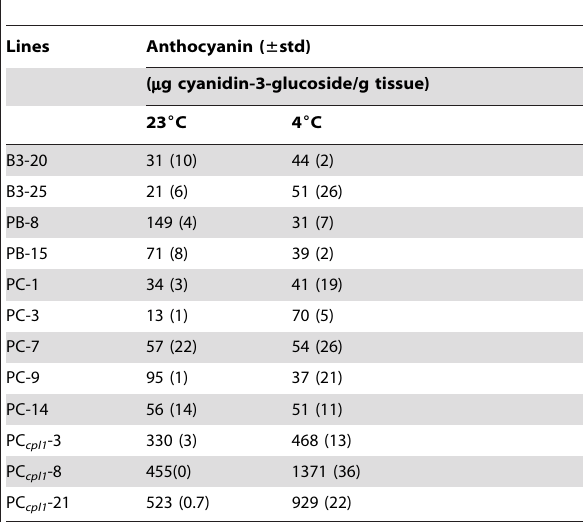
Table 1. Anthocyanin levels in representative transgenic lines growing at 23 u C or 4 u C.